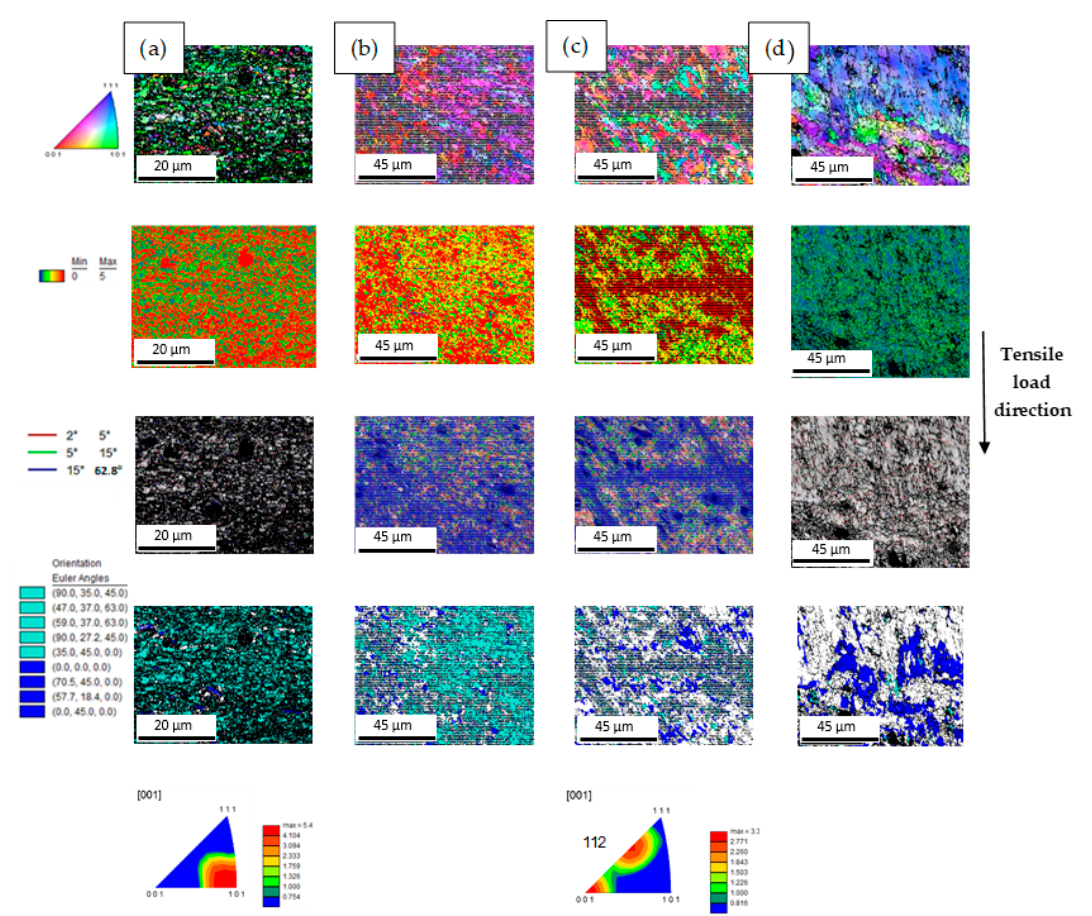
Figure 11. EBSD scans and respective maps for sample ( a ) rc.AR, ( b ) rc.RD, ( c ) rc.45 and ( d ) rc.TR. Table 5. KAM values, misorientation, and texture components of the recovered sheet sample.